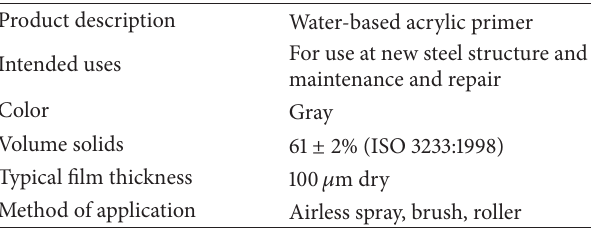
Table 1: Technical sheet of studied paint from our